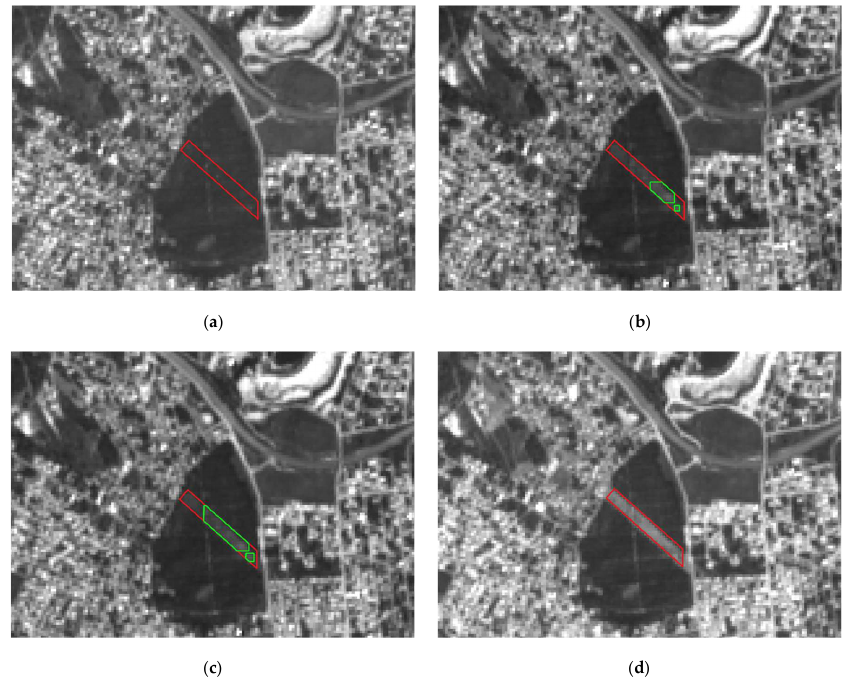
Figure 7. Sentinel-2 Band 04 images from an FB maintenance operation in Marisol (in red the total area, in green the operated area): ( a ) before (30-01-2018), ( b ) completeness of 28% (22-02-2018), ( c ) completeness of 61% (24-02-2018) and ( d ) completed (26-03-2018).